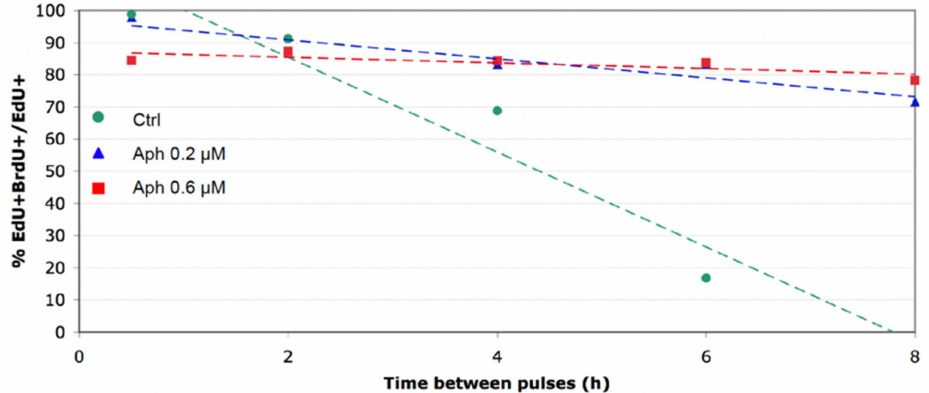
Figure 5. Effect of aphidicolin on S-phase duration. Linear regression of the fraction of EdU + BrdU + /EdU + cells after treating MEFs with no (Ctrl), 0.2 µ M or 0.6 µ M aphidicolin. Estimated S-phase durations are 8.5 h, 31 h and 124 h,